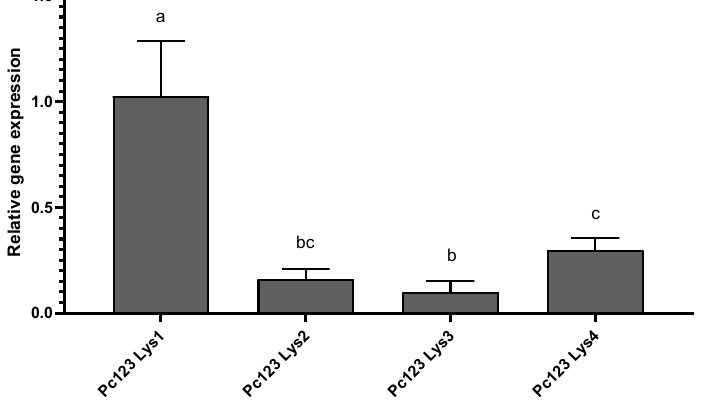
Figure 5. Putative Pc123 LysM effectors expression in banana roots. All four genes encoding putative LysM effectors are expressed constitutively by the fungus. Pc123 Lys1 is the most expressed gene. Genes encoding Pc123 Lys2, 3 and 4 are expressed ca. 6.25-, 10- and 3.35-fold less, respectively. One-way ANOVA analysis was performed ( p < 0.05). Letters (a,b,c,d) indicate significant differences.